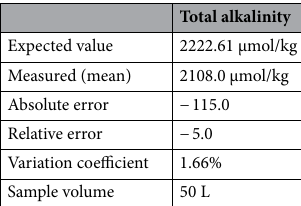
Table 2. Total alkalinity measured from five replicates of the certified reference material (Dickson, oceanic CO 2 measurements, batch